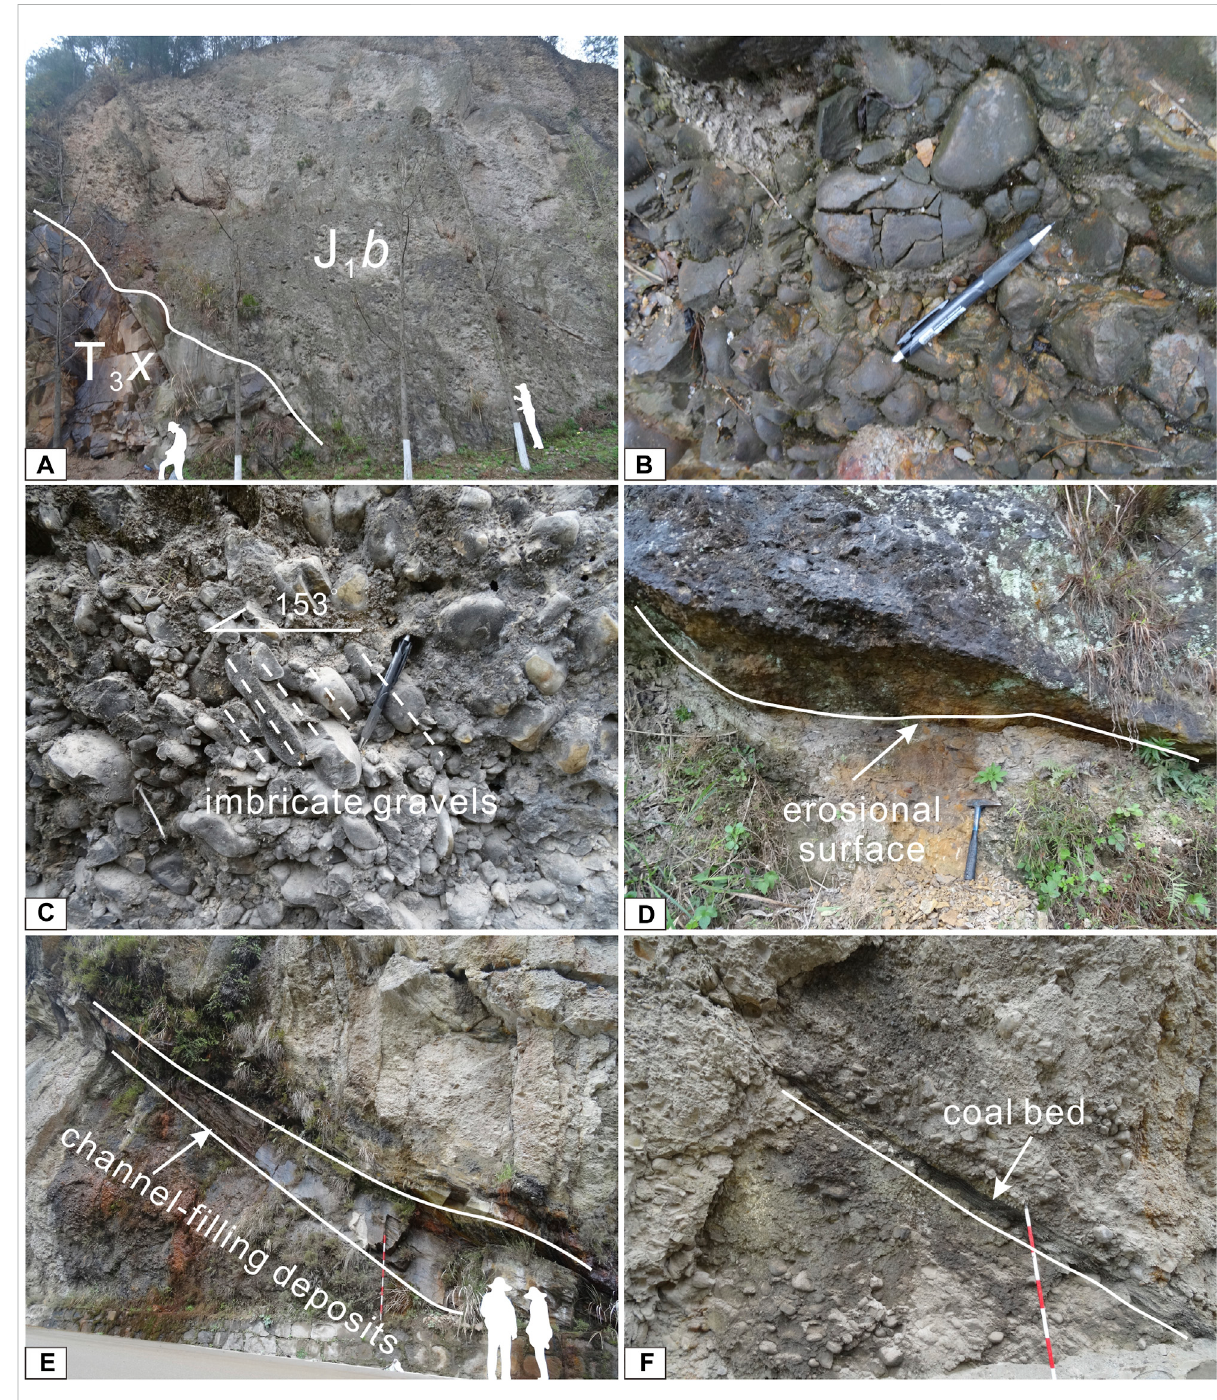
FIGURE 2 Photographs of the Lower Jurassic strata in the Jinzishan outcrop, northwestern Sichuan Basin. (A) The unconformity between Upper Triassic Xujiahe Fm and the overlying Baitianba Fm. (B) The well-rounded nature of the quartz clasts forming the Baitianba conglomerate. (C) Gravel imbrication indicates southeastward paleo fl ows. (D) Represents an erosional basal surface. (E) Channel- fi lling deposits. (F) Shows an interbedded coal